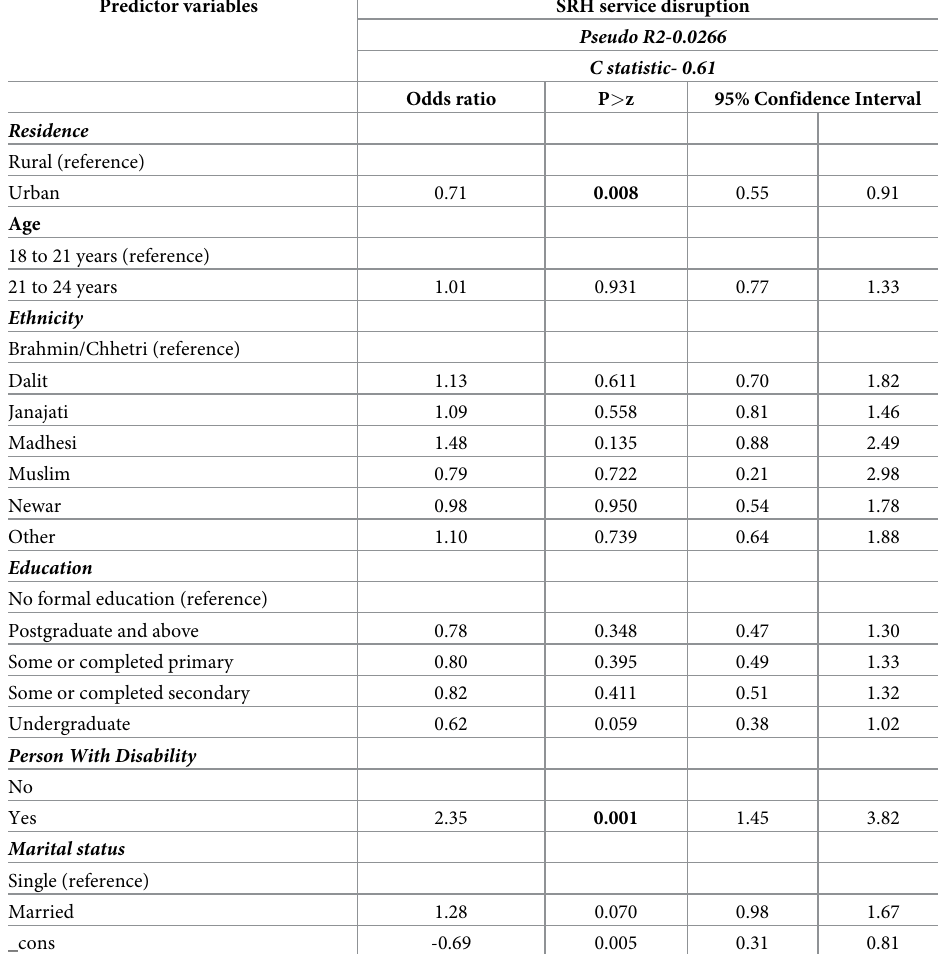
Table 6. Regression models looking at association between experience of SRH service disruption and sociodemo- graphic variables. Predictor